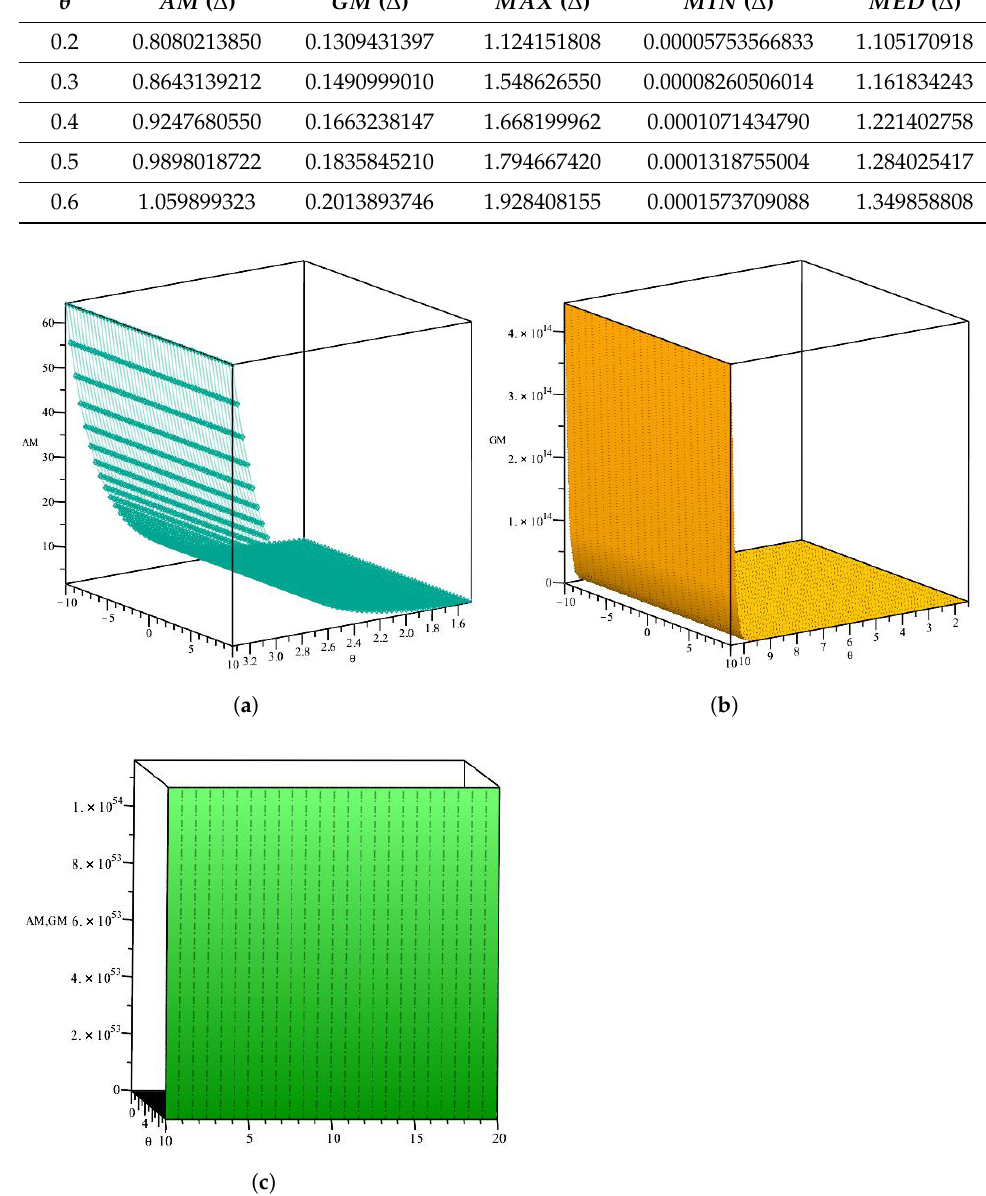
Figure 1. Graph of aggregate functions AM and GM for, τ = 2 and different values θ . ( a ) The aggregation arithmetic mean function for θ ∈ ( 3 for θ ∈ ( 1.5,10.5 ) . ( c ) The aggregation geometric mean function for θ ∈ ( 0,10 )